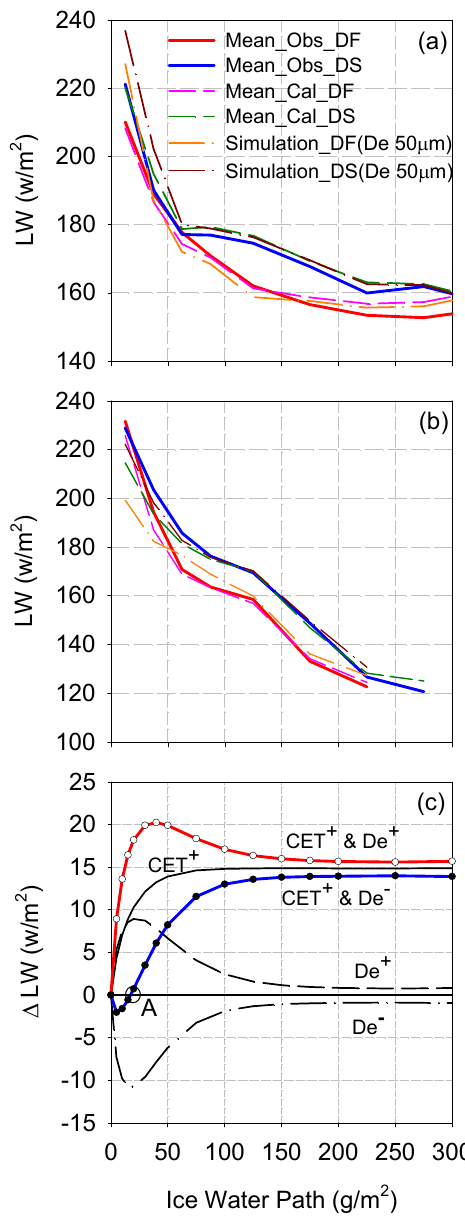
Fig. 6. Comparison of observed upward TOA long wave flux with: 1) that calculated employing both cloud effective temperature and ice effective diameter retrievals; 2) that simulated using cloud effec- tive temperature distribution function without taking into account size impacts during (a) daytime and (b) nighttime. (c) A con- ceptional explanation of the impacts of cloud effective temperature (CET) and ice effective diameter (De) on upward TOA long wave flux. The control run was made at CET − 40 ◦ and De 50µm. Other calculations under warmer CET (CET+, at cloud effective height 1km lower), larger De (De+, 70µm), smaller De (De-,30µm), and combinations of changes of CET and De (CET+ and De+; CET+ and De-) were made, respectively. Curves shown here are the dif- ferences between these calculations and the